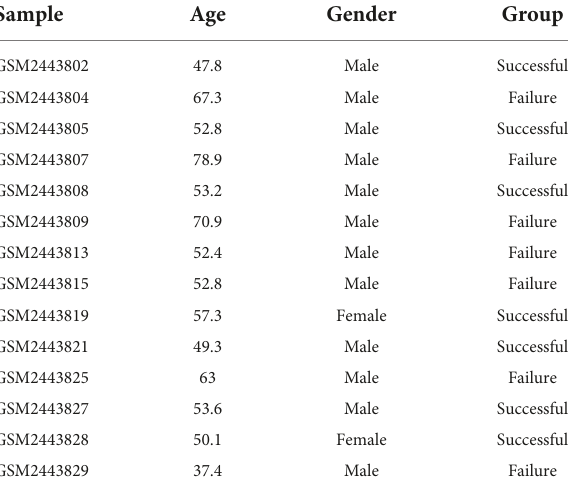
TABLE 1 Thegeneral clinical information of GSE93101 data